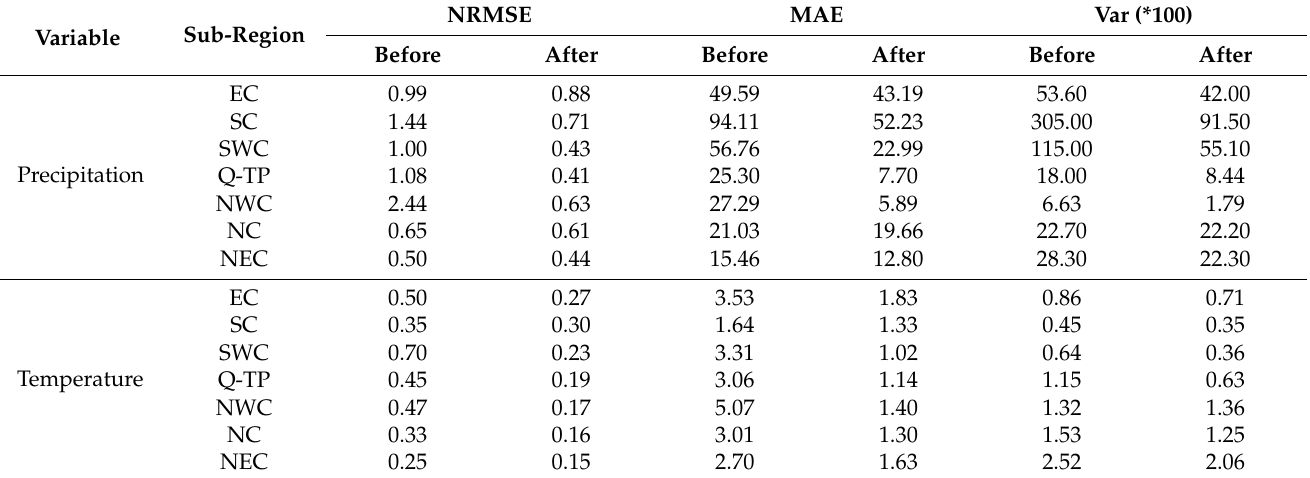
Table 2. The effect before and after correction of GCMs in historical